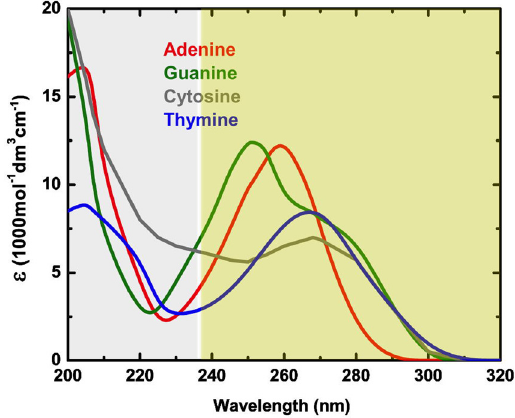
Figure 1: UV spectra of the DNA nucleotides (This figure is partly plotted from data published reference [35]).